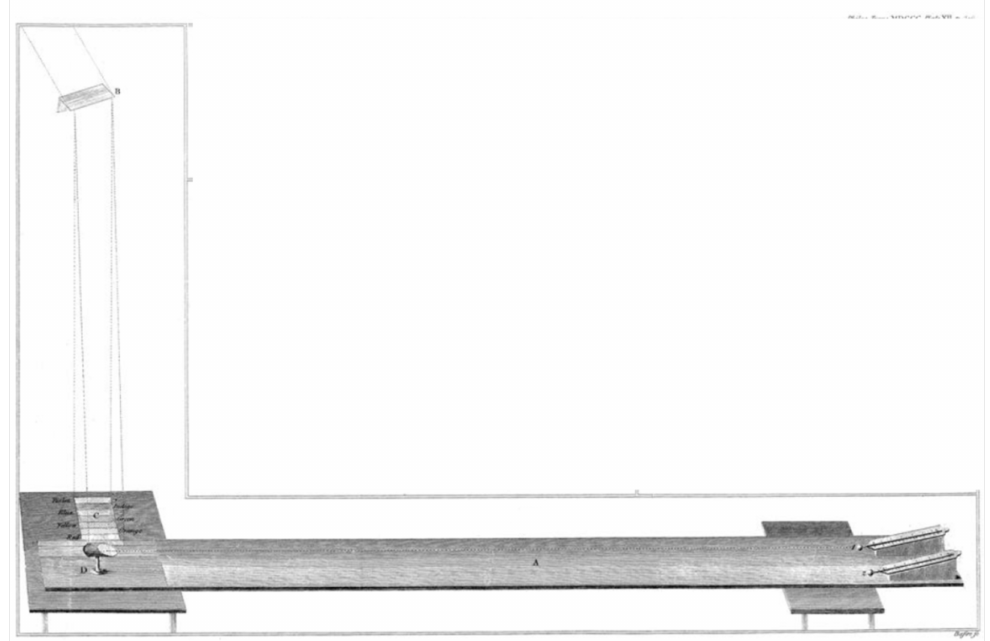
Figure 5. Measurement stand for infrared radiation reflection test—original drawing of the measurement stand [10]. A—the board that holds the apparatus used in experiment, B—the prism, C—the spectrum, thrown partly on the paper with parallel lines and partly on of the small tables which support the board, D—mirror which reflects the rays of heat sideways, 1—thermometer which receives the reflected rays, 2—the standard